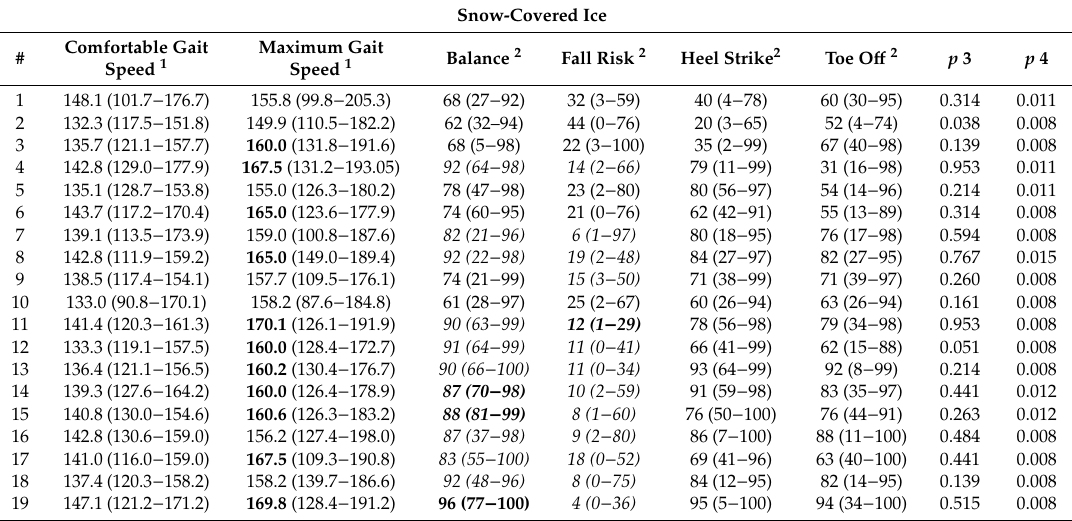
Table 4. Results of pedestrian gait speed and ratings of gait qualities during walk on the indoor test track with snow-covered ice surface with 19 anti-slip devices. Values are median